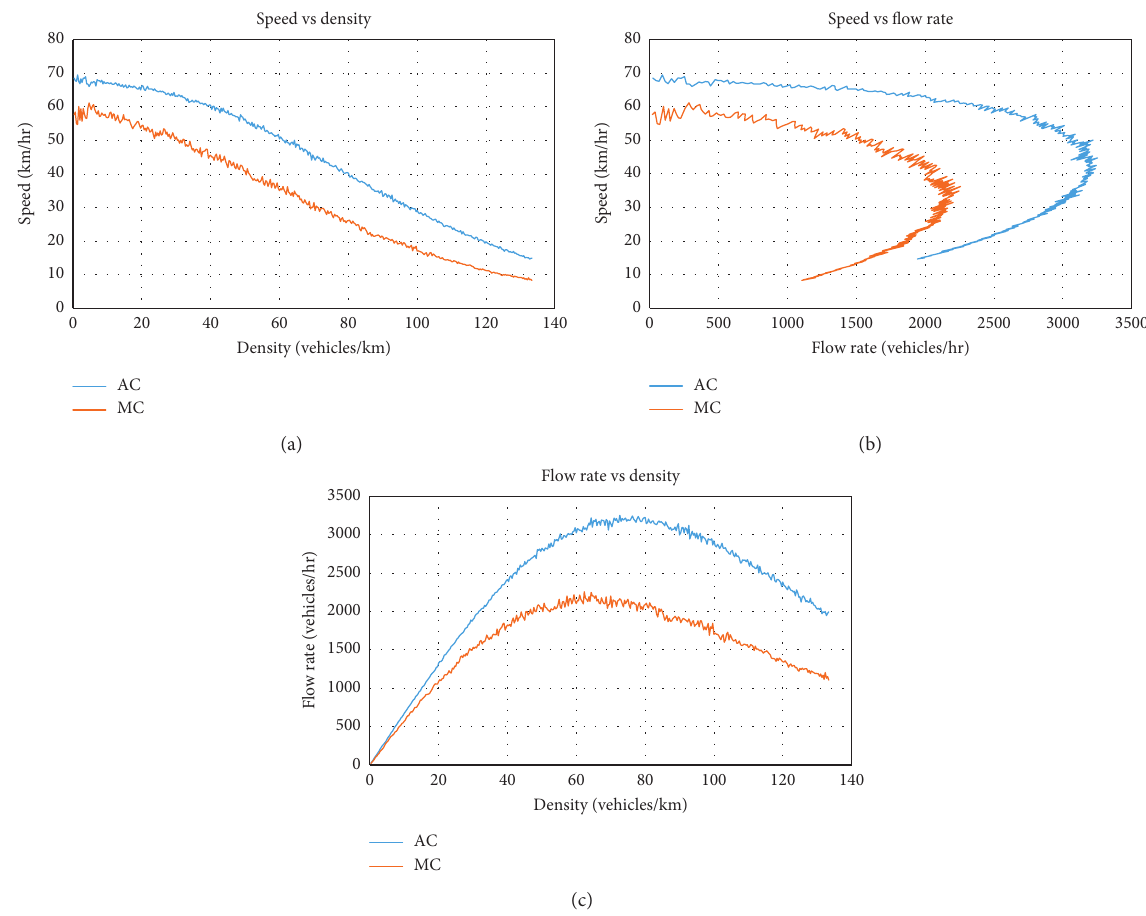
Figure 2: Traffic flow fundamental diagrams for 100% AC and